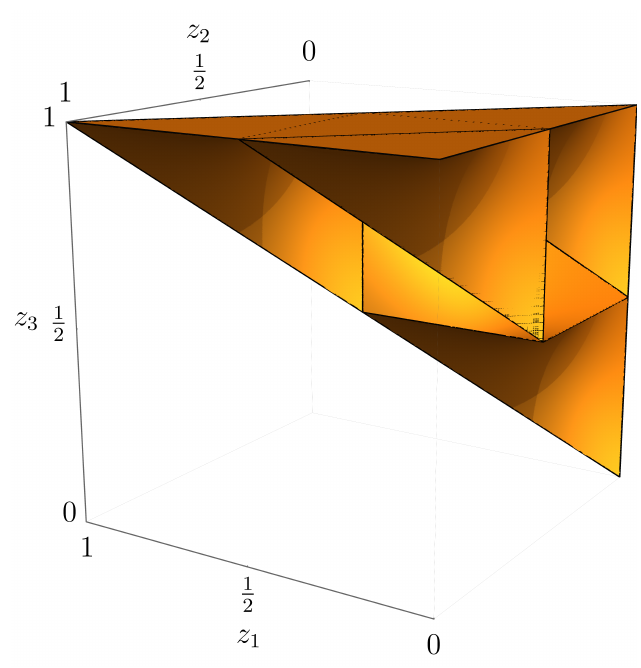
) -space where Trop < 0. The picture is , z , z 1 2 3 . 2